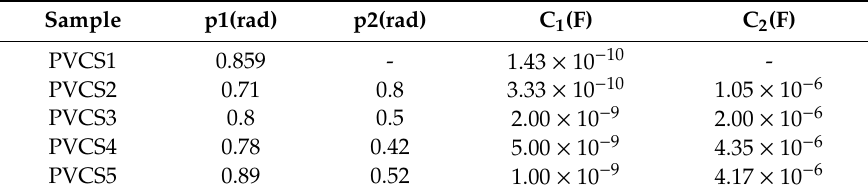
Table 3. Fitting parameters of the EEC for electrolyte films at room